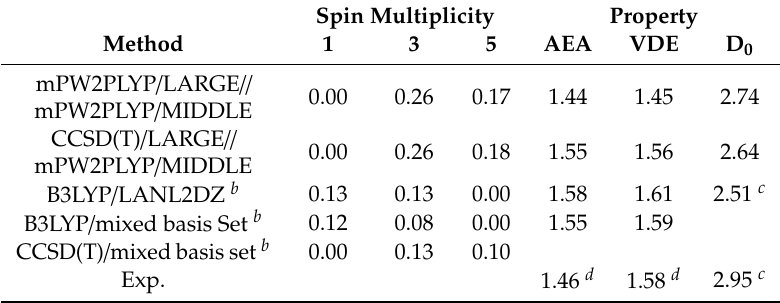
Table 3. The relative energy of ZrSi between di ff erent spin multiplicities along with predicted